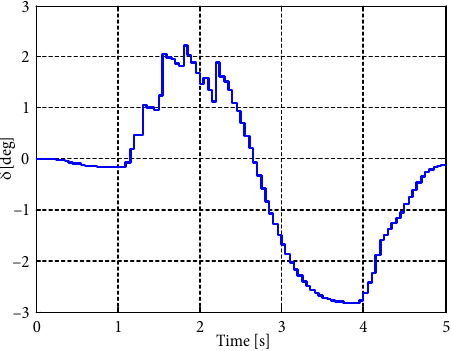
Fig. 8. Steering angle (lane-change